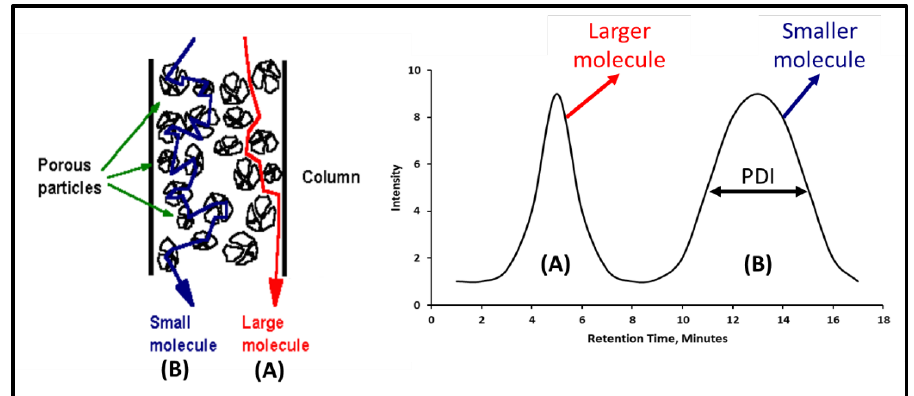
Figure 2. Simplified Gel Permeation Chromatography (GPC) illustration and example showing that molecule A size > molecule B size, and molecule B PDI > molecule A PDI.